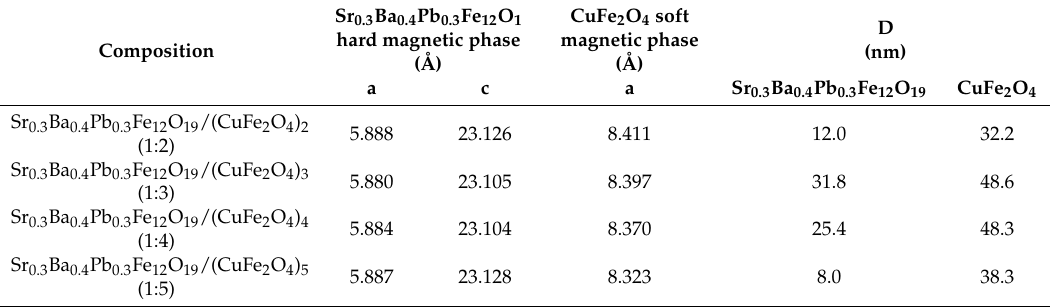
Table 1. The features of the crystal structure (a and c unit cell parameters and D—average